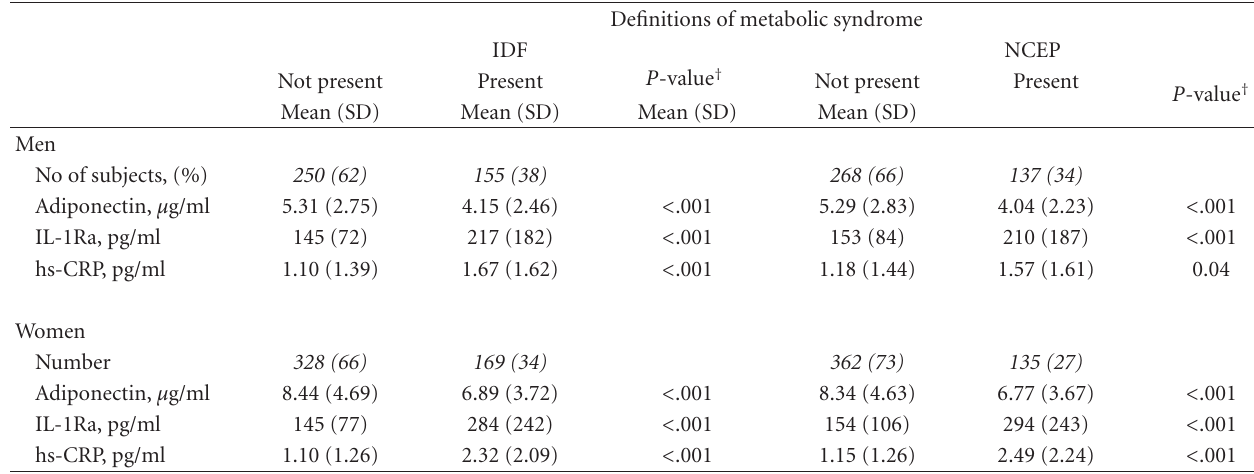
Table 2: Adiponectin, interleukin-1 receptor antagonist (IL-1Ra), and high-sensitivity C-reactive protein (hs-CRP) levels according to the IDF and the NCEP definitions of metabolic syndrome in men and women.